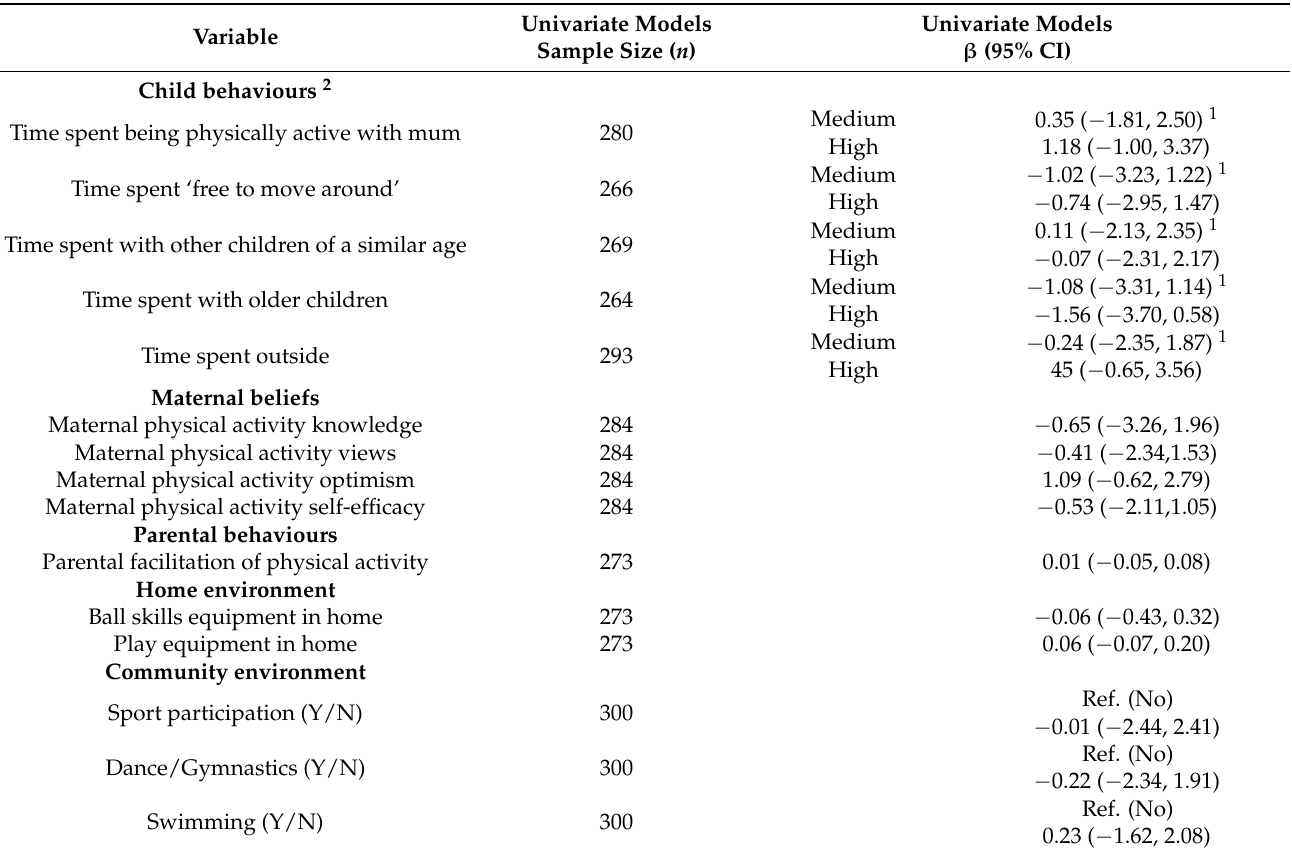
Table 4. Correlates of 5-year-old children’s perceived motor skill competence